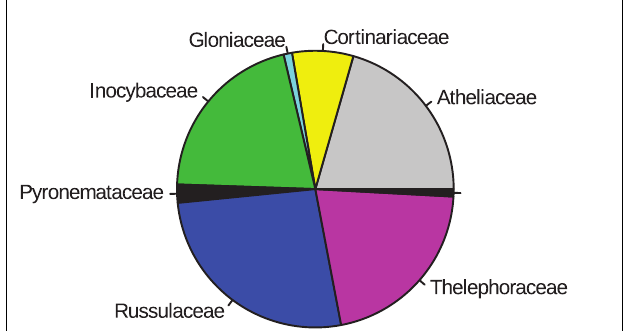
FIGURE 4 | Pie chart representing percent of EMF families per stand type for root tips samples of BF saplings (based on the abundance of reads). BS, black spruce; BSE, black spruce plus ericaceous shrub; TA, trembling aspen.